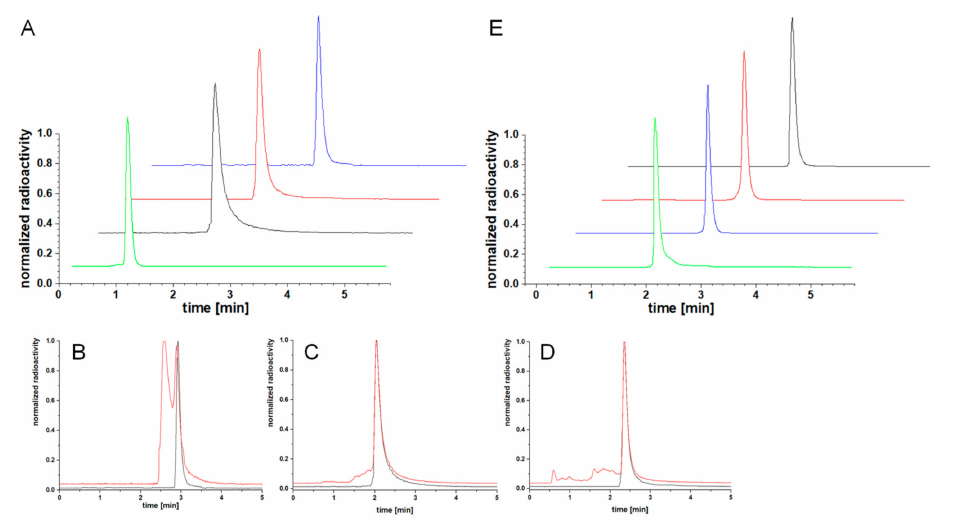
Figure 4. Radio-HPLC chromatograms of [ 68 Ga]Ga- 10 –[ 68 Ga]Ga- 12 and [ 68 Ga]Ga- 19 ([ 68 Ga]Ga- 10 : blue; [ 68 Ga]Ga- 11 : black; [ 68 Ga]Ga- 12 : red; [ 68 Ga]Ga- 19 : green) ( A ). Radio-HPLC chromatograms of [ 68 Ga]Ga- 10 –[ 68 Ga]Ga- 12 from left to right; black traces: radiolabeling with tris(2-carboxyethyl)phosphine (TCEP), red traces: radiolabeling without TCEP ( B – D ). Radio-HPLC chromatograms of [ 68 Ga]Ga- 14 –[ 68 Ga] Ga- 17 ([ 68 Ga]Ga- 14 : black; [ 68 Ga]Ga- 15 : blue; [ 68 Ga]Ga- 16 : red; [ 68 Ga]Ga- 17 : green) ( E ). Analytical HPLC chromatograms were obtained using a gradient of 0% H 2 O–100% MeCN ( + 0.1% trifluoroacetic acid (TFA)) in 5 min. Table 1. Summary of the chemical, biological and photophysical properties of the NIR fluorescent dyes 1–3 , the corresponding MIS 10 – 12 and 19 and the PESIN (PEG 3 -BBN 7–14 )-homodimer conjugates 14 – 18